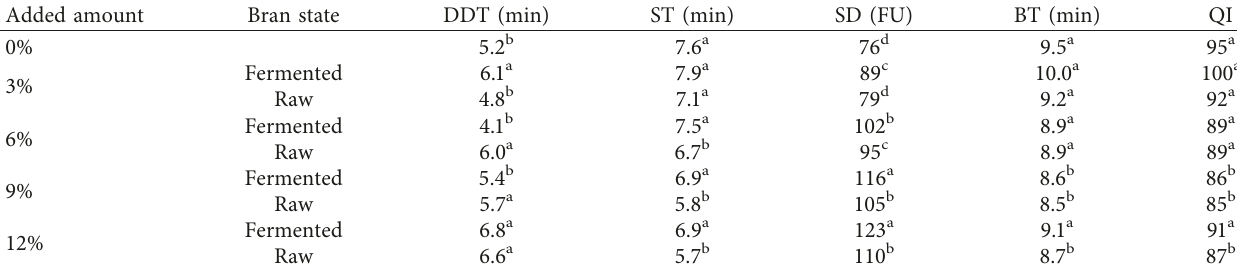
Table 1: Different amounts of added bran and the farinographic properties of the mixed flour. Added amount